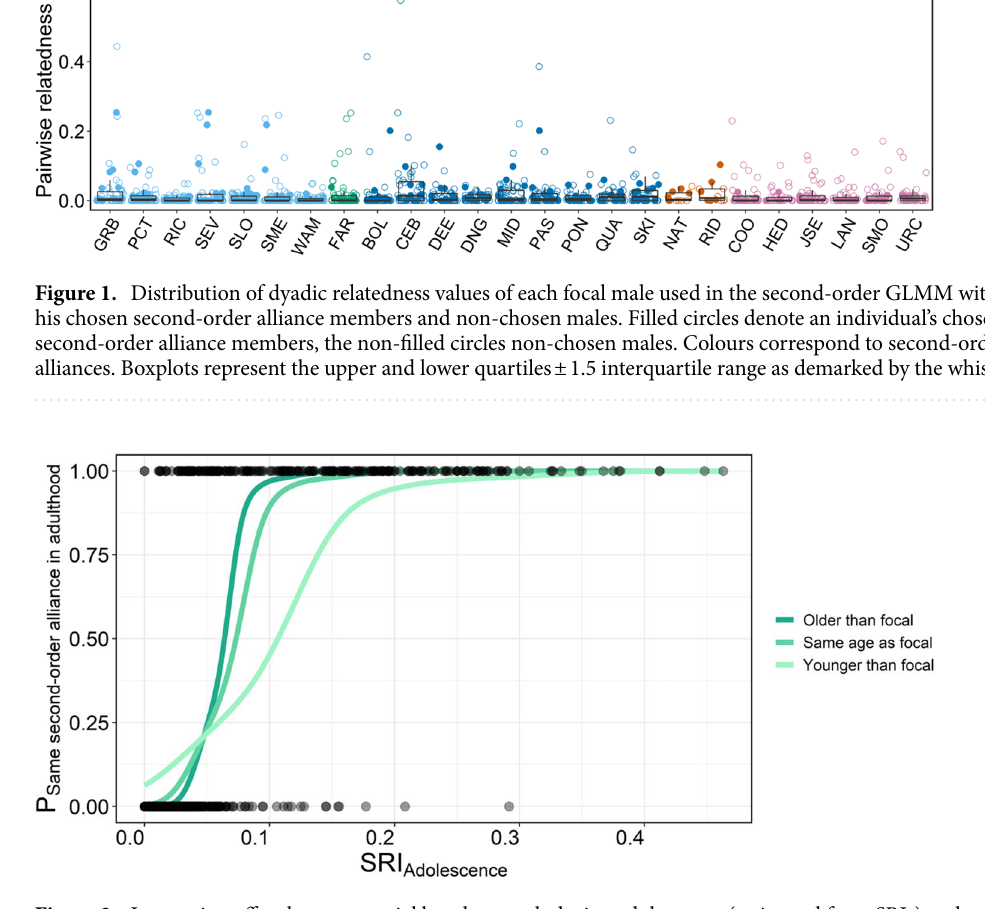
Figure 2. Interaction effect between social bond strength during adolescence (estimated from SRIs) and age difference on second-order alliance membership in adulthood. Focal males were more likely to be second-order alliance members in adulthood with males they associated with more often during adolescence, denoted by higher SRI values. However, older males and those of the same age were more likely to be chosen at lower SRI levels compared to younger